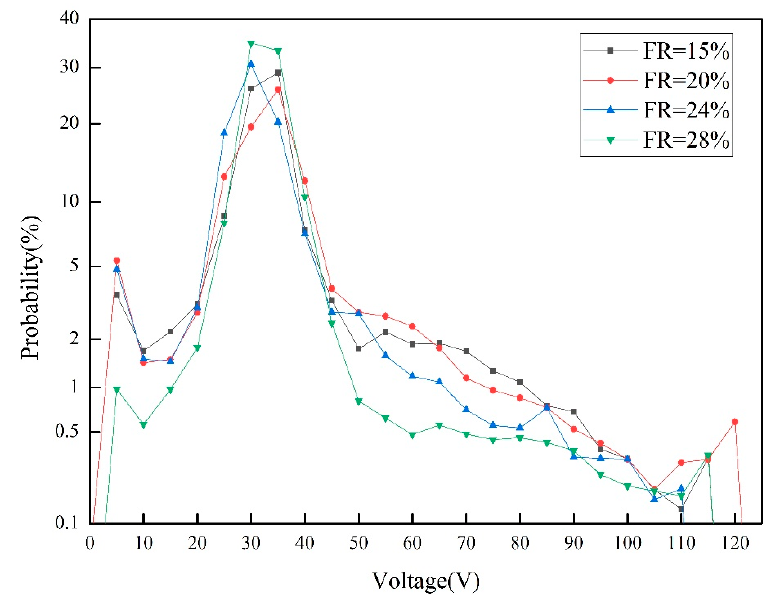
Figure 5. The effect of filling rate on probability of voltage distribution. Figure 5. The e ff ect of filling rate on probability of voltage